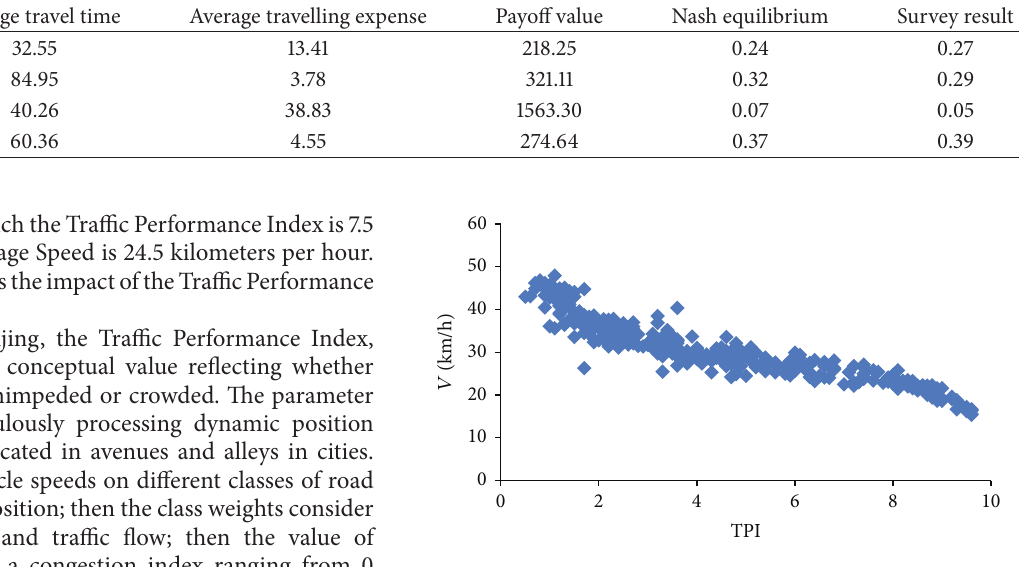
Figure 5: Scatter plot for relationship between TPI and Regional Average